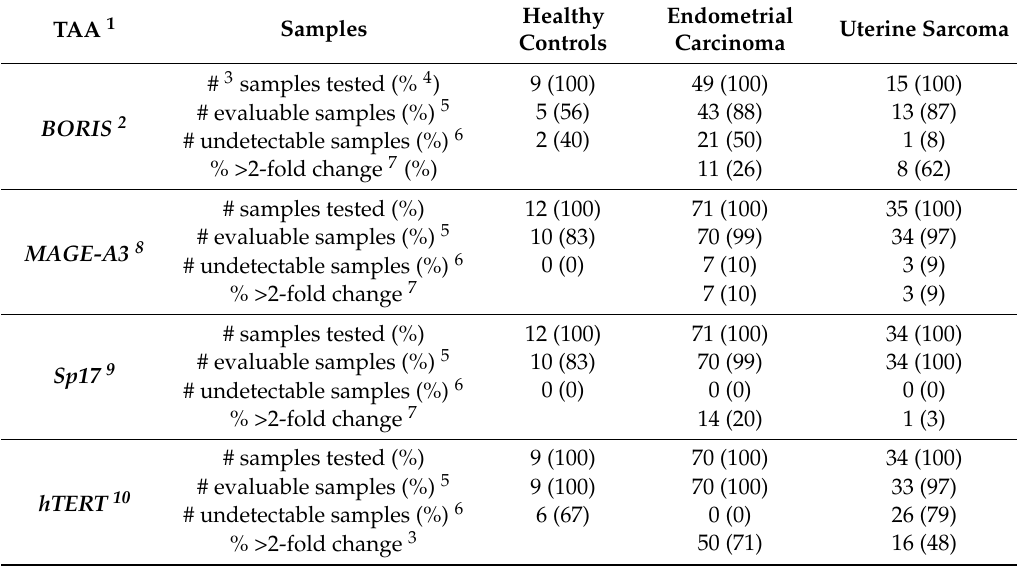
Table 1. Evaluation of TAA expression in patient biopsies by